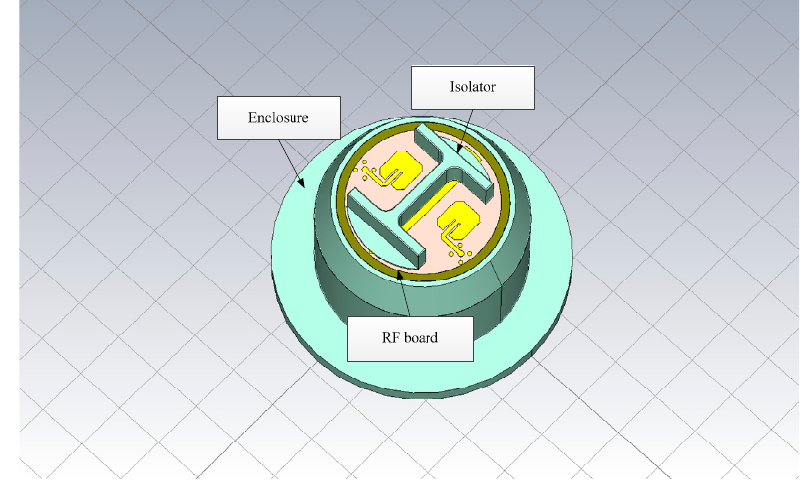
Figure 5. The external structure of the field model.